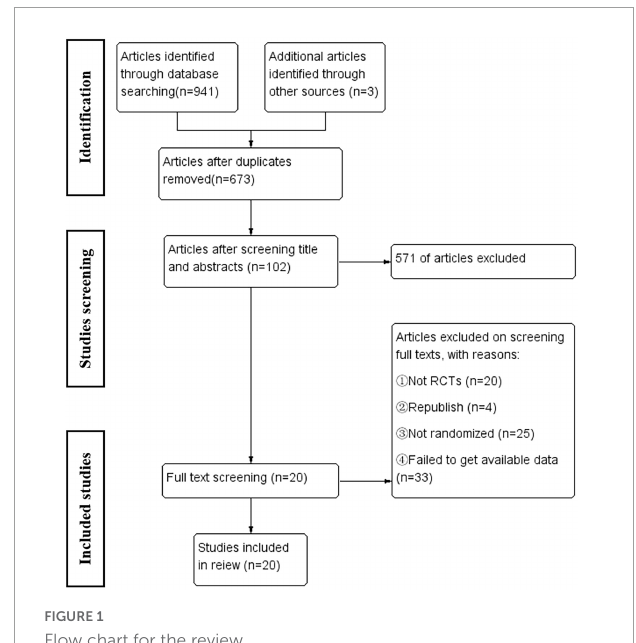
FIGURE1 Flow chart for the